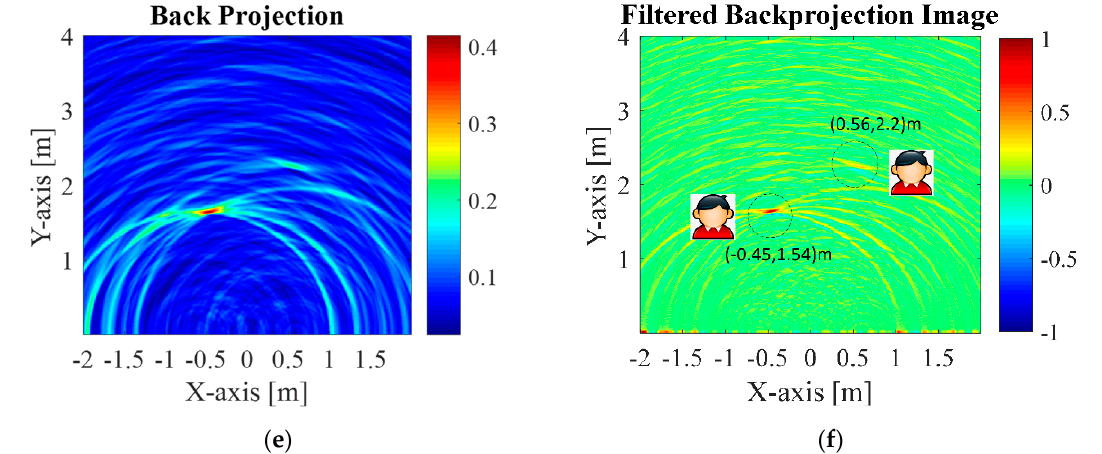
Figure 10. Through-the-wall detection of two human subjects at ( − 0.5 m, 1.5 m) and (0.5 m, 2 m) and a mannequin at (0,1 m): ( a ) the experimental scene with two real humans and mannequin, ( b ) raw data of each channel; ( c ) statistical variance analysis of each channel, ( d ) statistical variance analysis of each channel on 2D display, ( e ) radar imaging by back projection, ( f ) refined radar imaging using Sinc-filtered back projection.